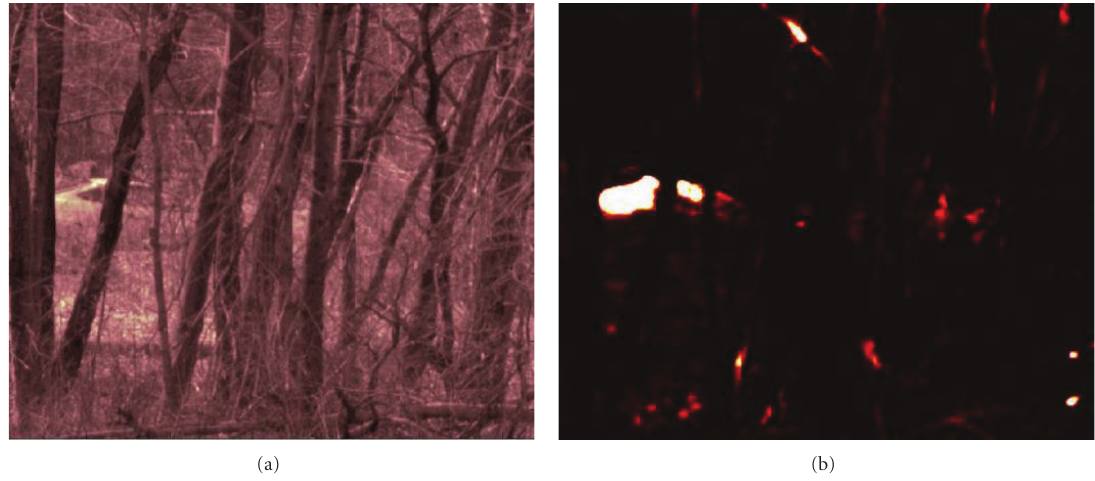
Figure 11: Results testing Cube 4 (a) and corresponding output surface (b). Parameters were set to ( q = 0 . 10; T 1 = T (20); N = 22; M = 40). A motor vehicle is shown on the left hand side, between top and bottom, behind tree trunks—a sport car. Cube 4 exemplifies a hard case of autonomous clutter suppression. Using the available ground truth information of the scene, the white clusters cover about 44% of the motor vehicle’s spatial area and less than 2% of false alarms.